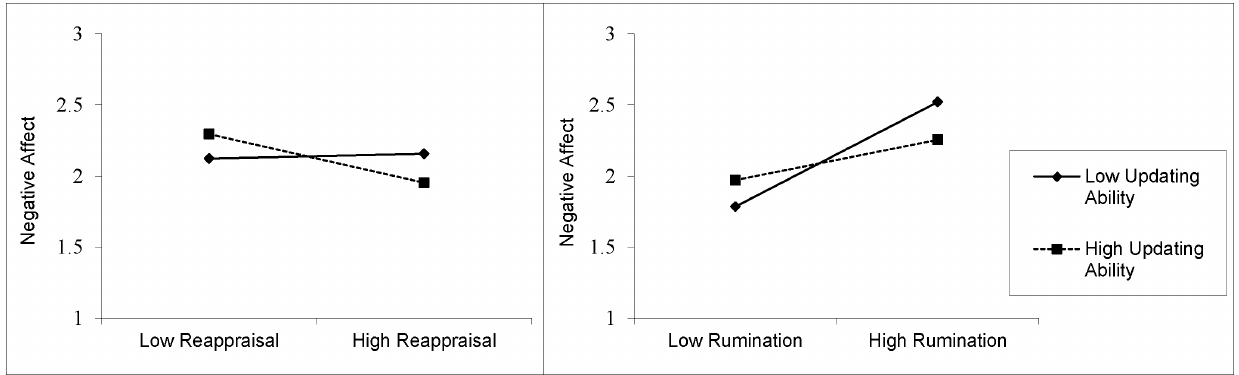
Figure 1. Illustration of the moderating effect of overall updating ability (as measured by the emotional n -back) on the relationship between reappraisal (left panel) and rumination (right panel) on NA at the trait level. Dashed and straight lines represent participants with low (-1 SD ) and high ( + 1 SD ) n -back scores, respectively. Low and high reappraisal scores are -1 SD and + 1 SD from the overall mean, respectively. Low and high rumination scores were coded similarly.